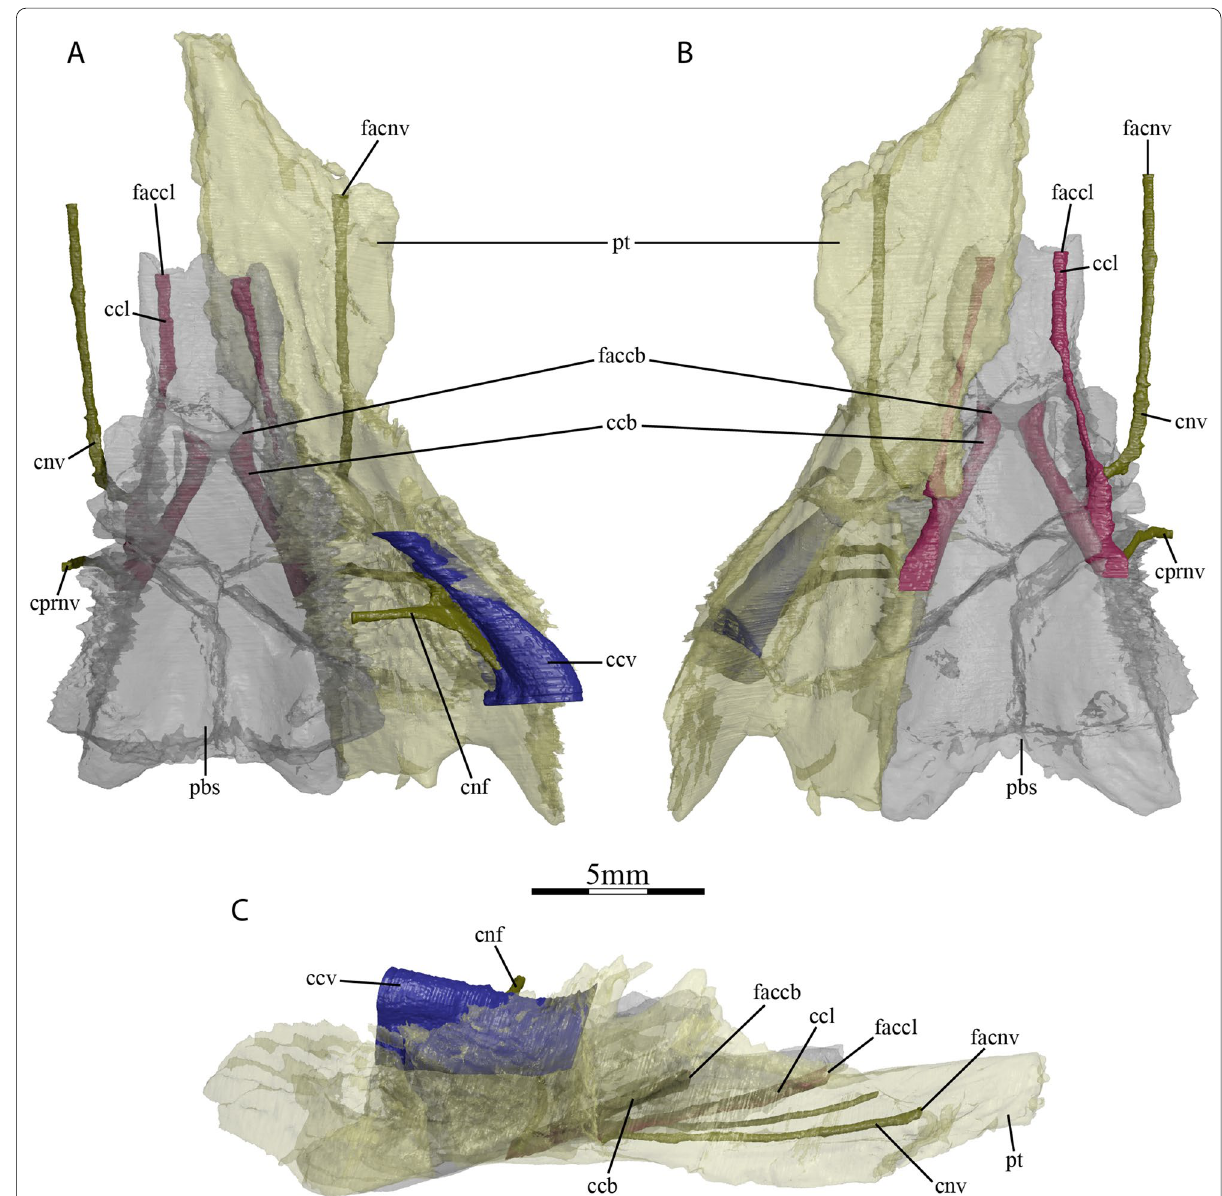
Fig. 5 Three-dimensional reconstructions of the parabasisphenoid, right pterygoid, lateral head vein circulation, carotid circulation, and facial nerve system of UCM 53971. A Dorsal, B ventral, and C right lateral view. ccb canalis caroticus basisphenoidalis, ccl canalis caroticus lateralis, ccv canalis cavernosus, cnf canalis nervus facialis, cnv canalis nervus vidianus, cprnv canalis pro ramo nervi vidiani, faccb foramen anterius canalis carotici basisphenoidalis, faccl foramen anterius canalis carotici lateralis, facnv foramen anterius canalis nervi vidiani, pbs parabasisphenoid, pt